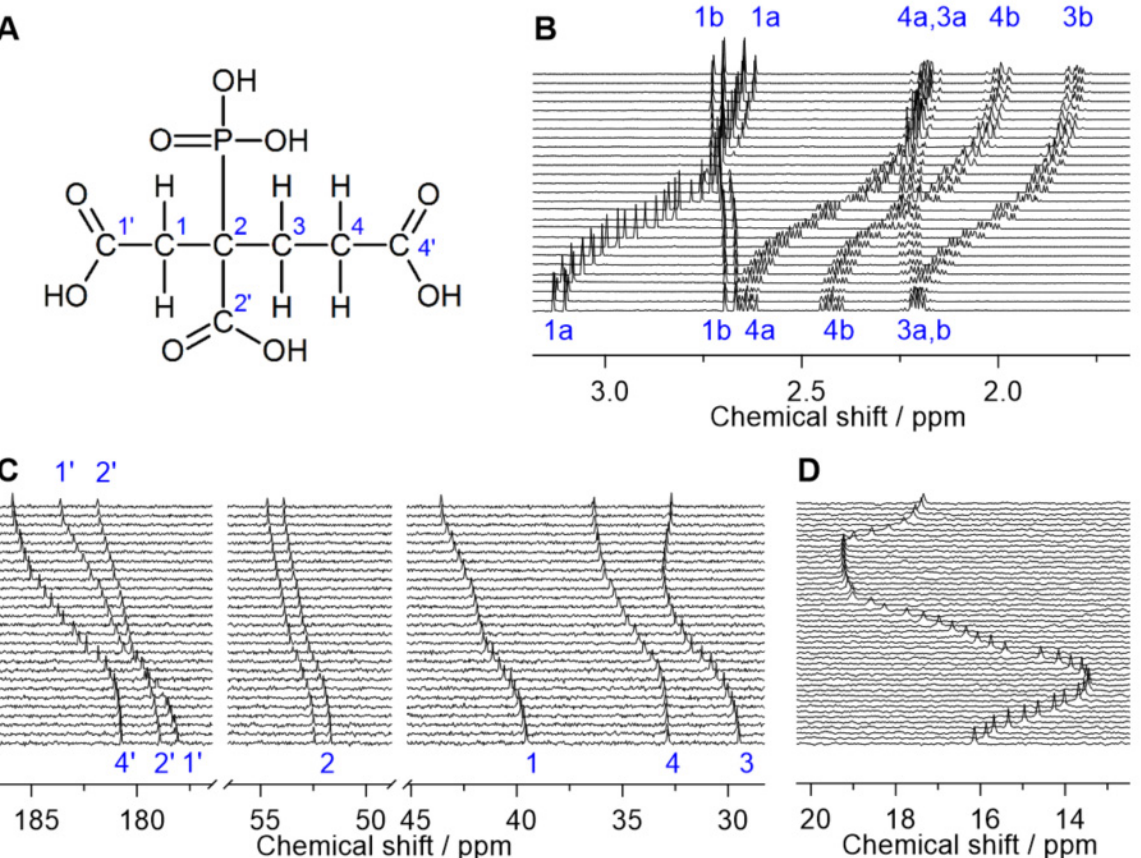
Figure 1. ( A ) Structure of PBTC together with atomic labeling used throughout this work. ( B – D ) NMR pH-titration series of PBTC in 0.5 molal NaCl solutions. ( B ) 1 H{ 31 P} NMR and ( C ) 13 C{ 1 H} NMR spectra of 25 mM PBTC in the pH range 2–8, and ( D ) 31 P{ 1 H} NMR spectra of 1 mM PBTC in the pH range 0–11; pH values increase from bottom to top with increments of 0.2 to 0.4 pH units. For clarity, only spectral regions of interest are shown.